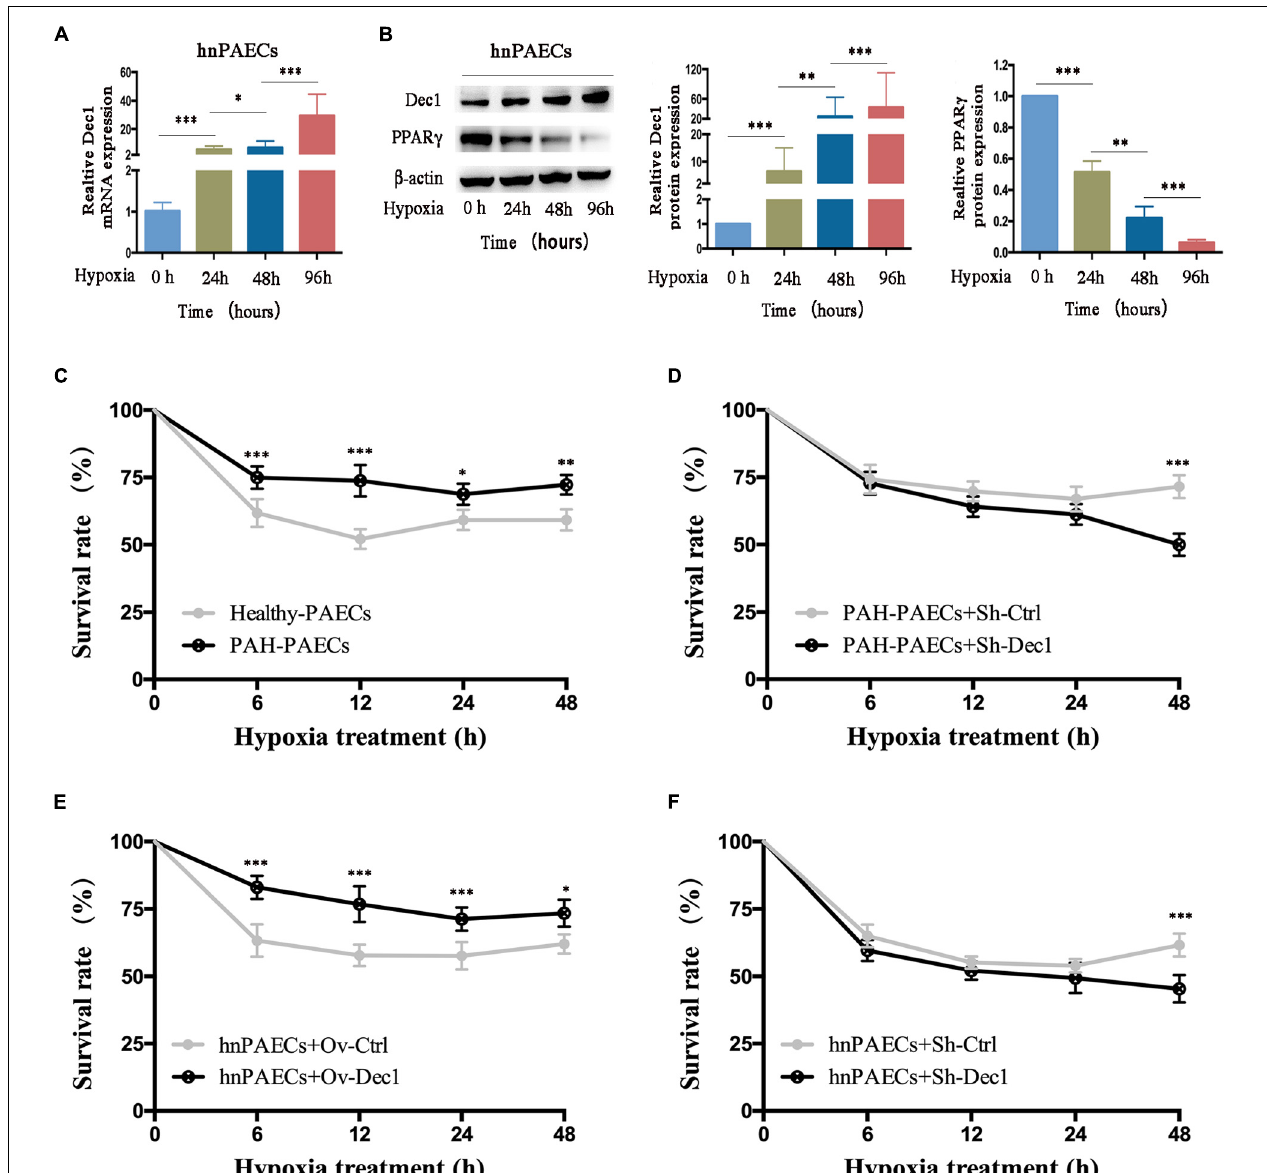
FIGURE 3 | Effect of Dec1 on PAECs survival under hypoxia. (A,B) Human normal PAECs (hnPAECs) were treated with 3% O 2 for 0, 24, 48, and 96 h and then performed real-time polymerase chain reaction (RT-PCR) or Western blot to determine the mRNA and protein levels of the target genes, respectively. (A) mRNA expression levels of Dec1. (B) Protein expression levels of Dec1 and PPAR γ . One-way ANOVA test was applied for statistical analysis. (C–F) After 12 h of transient transfection, cells were treated with 3% O 2 for 6, 12, 24, and 48 h and monitored the cell viability vs. time by the cell counting kit 8 (CCK-8) assay. Cells were plotted cell viability at the indicated times. (C) Healthy- and PAH–PAECs with no transfections. (D) PAH–PAECs transfected with Dec1-shRNA (Sh-Dec1) or the scrambled RNA (Sh-Ctrl) plasmids. (E) hnPAECs transfected with Dec1 overexpression (Ov-Dec1) or the empty control (Ov-Ctrl) plasmids. (F) hnPAECs transfected